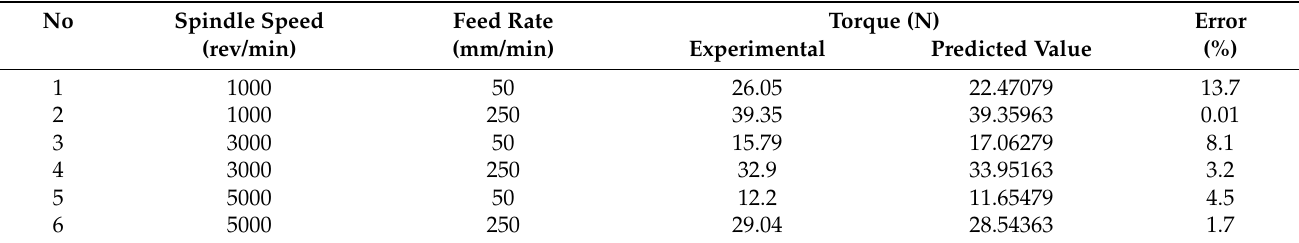
Table 8. Validation experiments for torque.